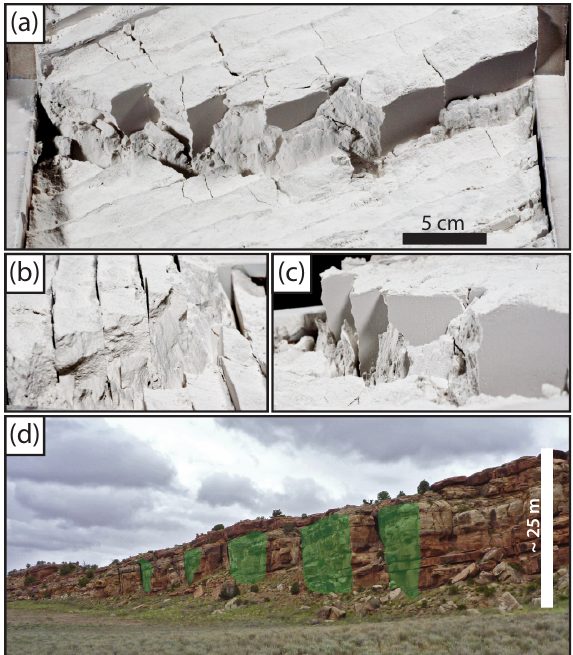
Figure 7. (a) Front view of the experiment with 25 ◦ JF-angle. (b) View from left side. (c) View from right side. (d) Comparable structures in Canyonlands National Park. Green areas mark joint surfaces.